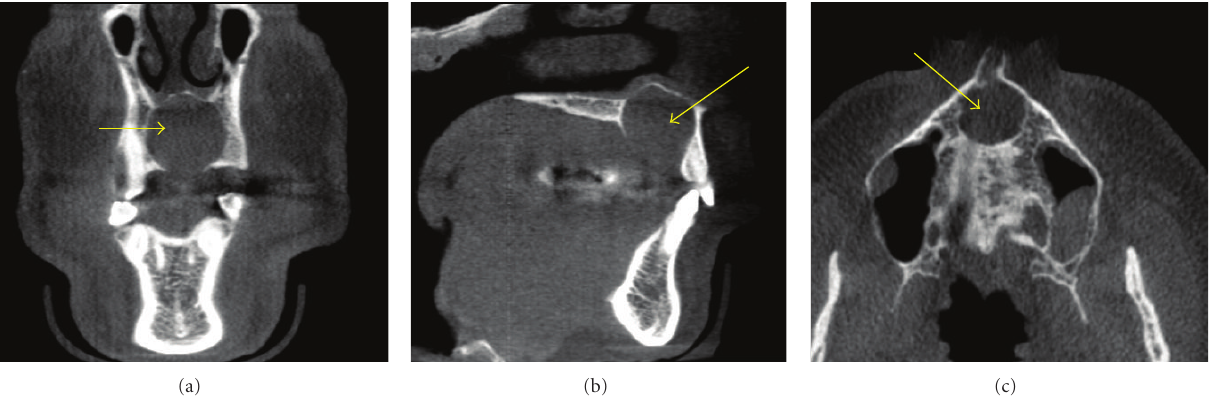
Figure 5: A nasopalatine canal cyst (arrows) is seen as a well-defined radiolucent entity in the maxilla in the midine in the regions of the nasopalatine canal. The inferior borders of this entity are not